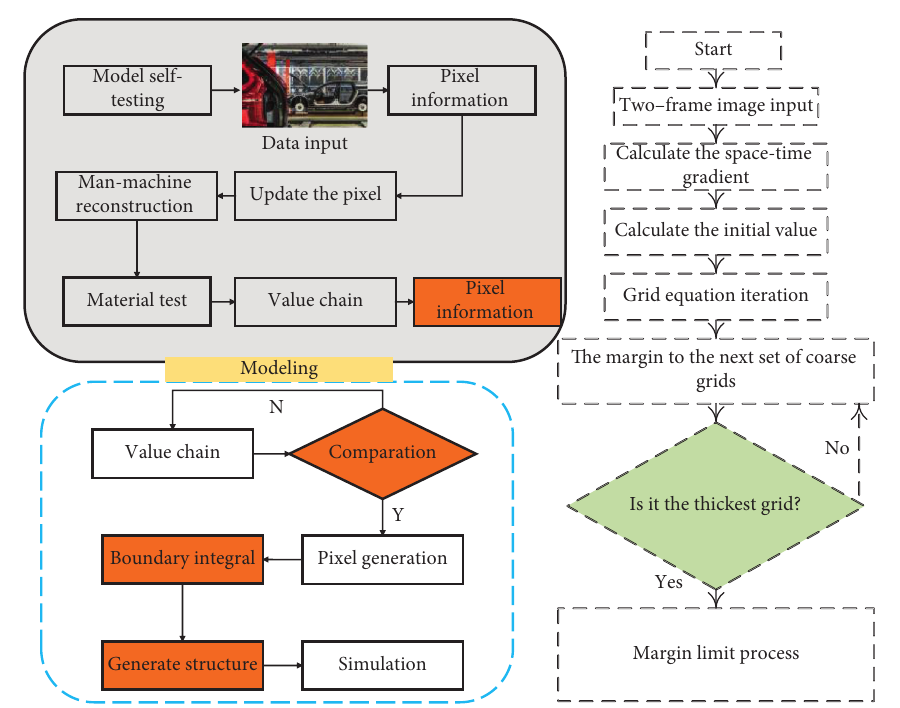
Figure 3: Accessory multivalue chain collaboration system.